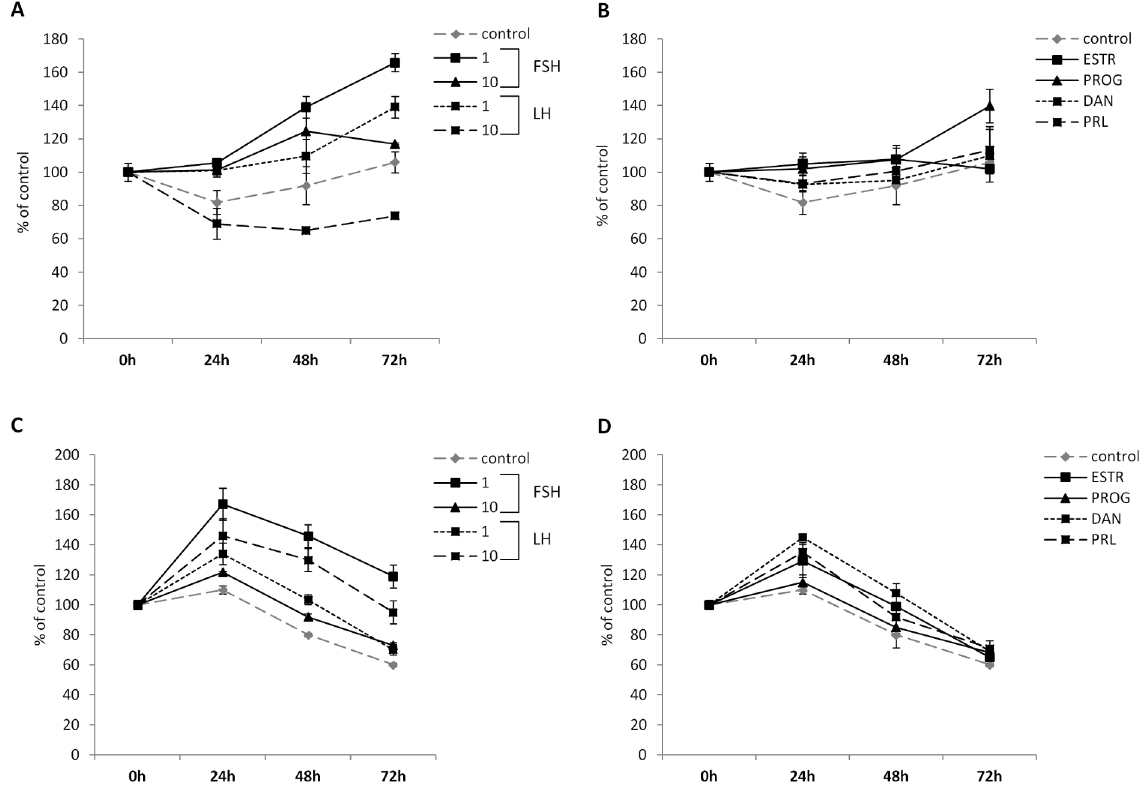
Fig 4. Effect of pituitary and gonadal glycoproteins on the proliferation of HTC116 (A, B) and HTB 37 (C, D) cells. Proliferation of HTC116 cells after treatment with (A) follicle-stimulating hormone (FSH, 1 and 10 IU/ml) or luteinizing hormone (LH, 1 and 10 IU/ml) or (B) estrogen receptor (ESTR, 100 nM), progesterone (PROG, 100 nM), danazol (DAN, 80 μ g/ml), or prolactin (PRL, 0.5 μ g/ml). Proliferation of HTB37 cells after treatment with (C) FSH (1 and 10 IU/ml) or LH (1 and 10 IU/ml) or (D) ESTR (100 nM), PROG (100 nM), DAN (80 μ g/ ml), or PRL (0.5 μ g/ml).